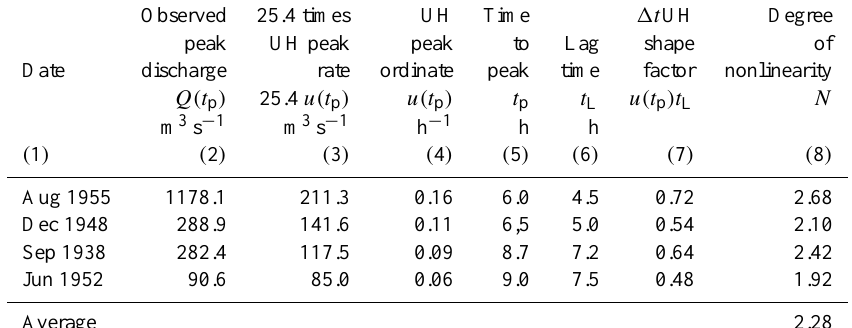
Table 3a. 3-hour unit hydrograph data for the Naugatuck River. Peak characteristics and calibration of the degree of nonlinearity. Observed